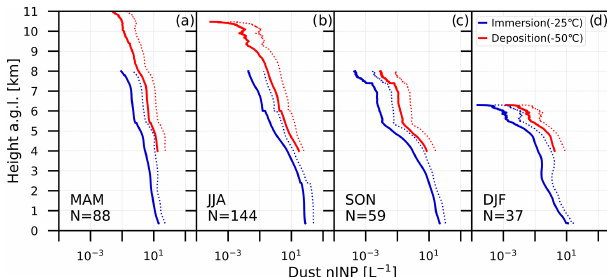
Figure 17. Same as Fig. 12 except for seasonal mean dust-related INP concentrations (nINP). The dotted lines show the (mean + SD) values. INP concentration is shown for fixed temperatures of − 25 ◦ C (blue, immersion freezing parameterization by DeMott et al. (2015) is used) and − 50 ◦ C (red, deposition nucleation param- eterization by Ullrich et al. (2017) for an ice supersaturation value of